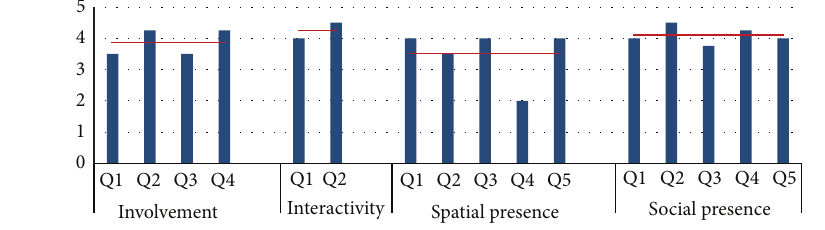
Figure 10: The average score of questions for the sense of presence questionnaire [42] answered by participants to measure the sense of presence in